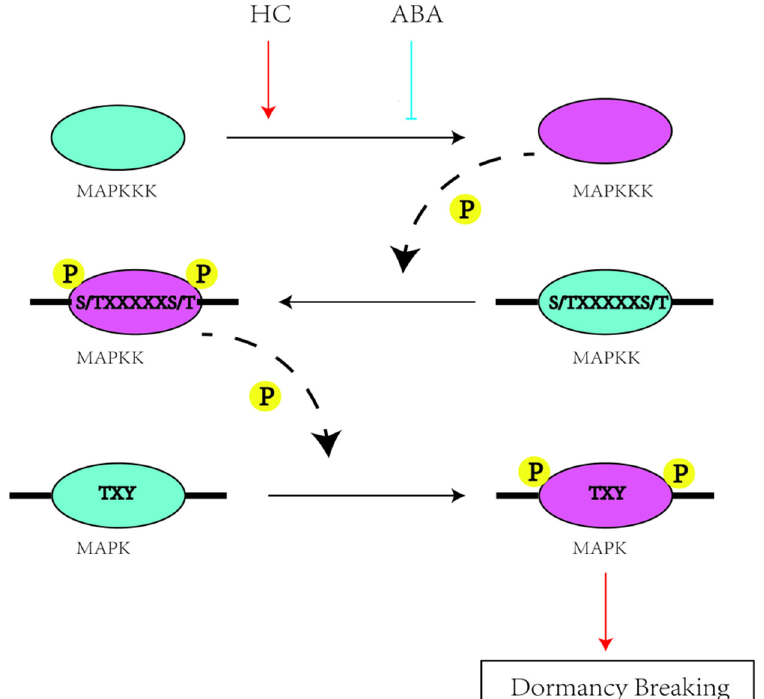
Figure 7. Possible pathways of MAPK cascade genes involved in the dormancy breaking in pear. Red lines with arrows denote a positive effect with an indirect interaction; Blue lines with T-ends indicate the inhibition through genetic interaction; Black dotted lines indicate phosphorylation. Blue ellipse represents an inactive state purple ellipse indicates the active state.